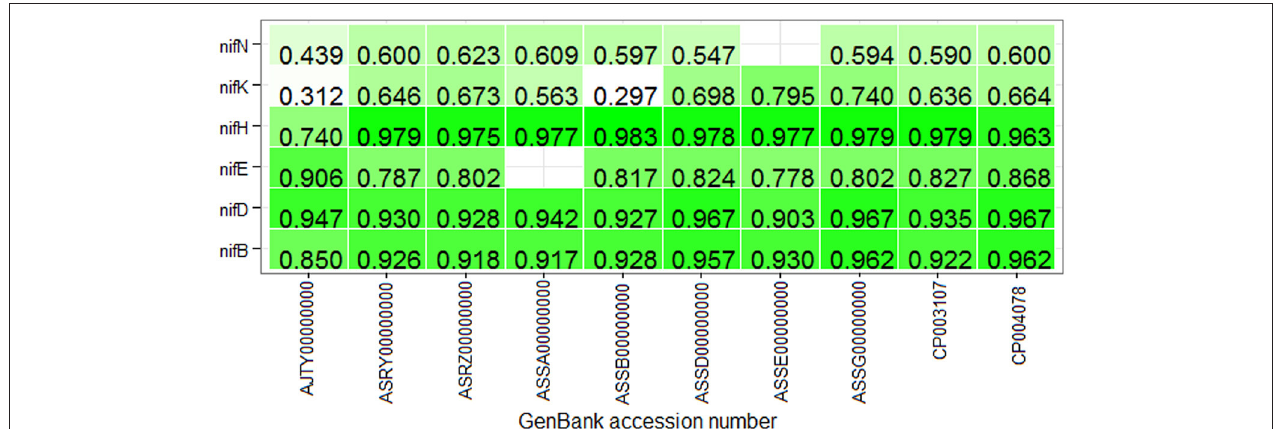
FIGURE 6 | Heat map of the prediction probabilities of nif protein sequences. It shows the probabilities with which the protein sequences of six categories of nitrogen-fixation are predicted in the second stage for the proteome-wide dataset of 10 diaztrophs. The color from light to dark represents lower to higher probabilities, and the blank cell indicates that no sequence was predicted in the corresponding category. Except one nifE and one nifN , all the nif sequences are correctly predicted. Further with the threshold 0.4, it is observed that except two nifK sequences all other nif sequences are correctly predicted in their respective